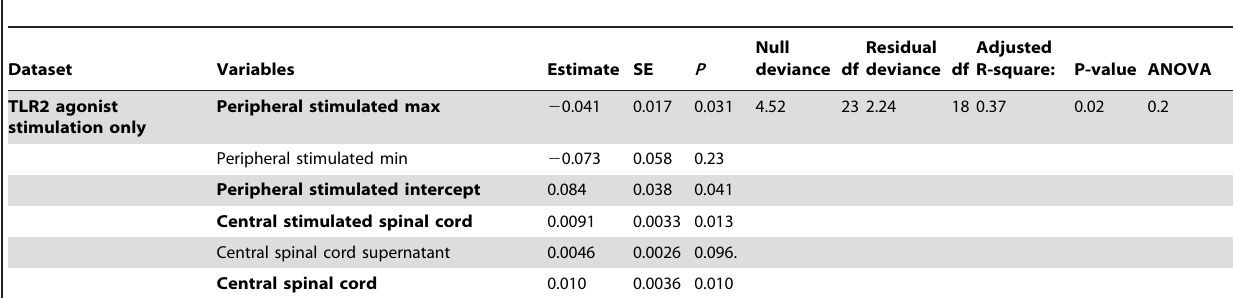
Table 6. Best-fit logistic regression model results for the prediction of the pain severity in rats post CCI in neuronal and subcutaneous experimental